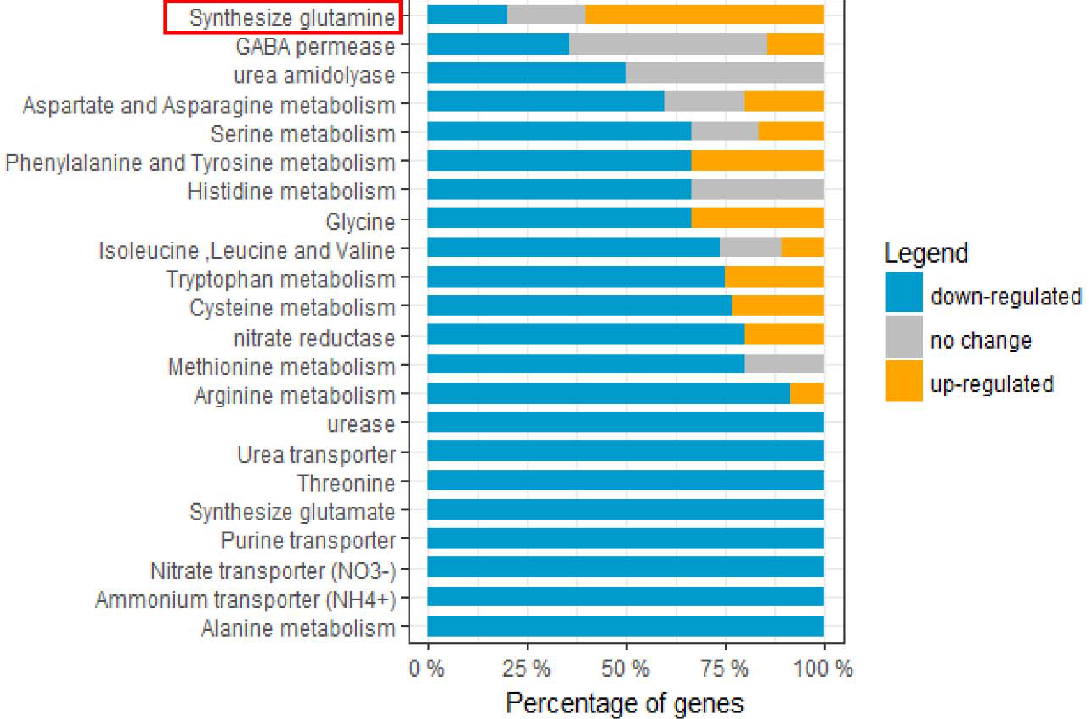
Figure 8. Nitrogen metabolism pathway responding to HSAF. The X axis indicates percentage of DEGs involving nitrogen metabolism. The Y shows the terms of GO category. The red box emphasizes that only one term, in which the number of up-regulated genes encoding synthesize glutamine were more than the number of down-regulated genes.